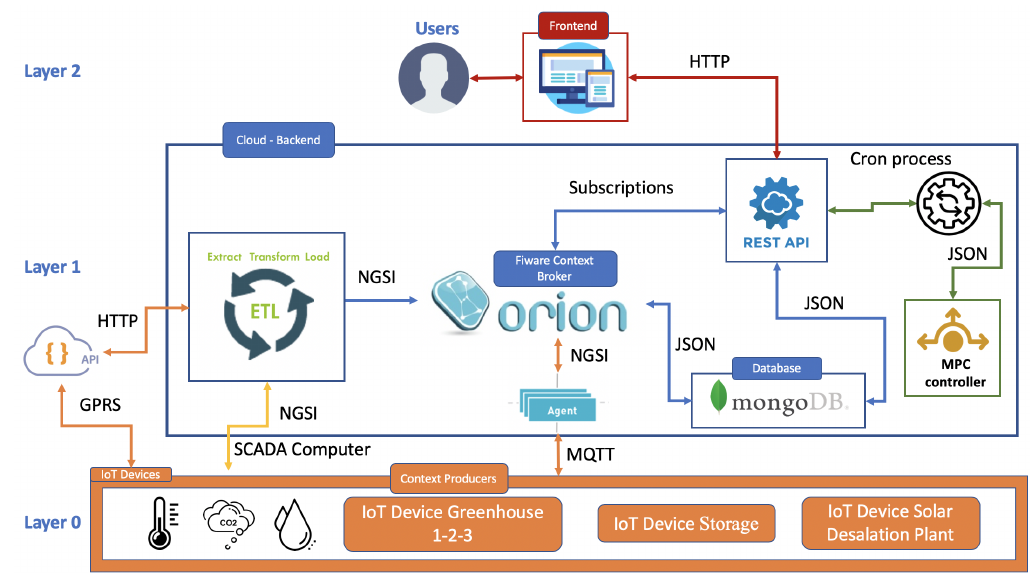
Figure 4. Architecture of the IoT